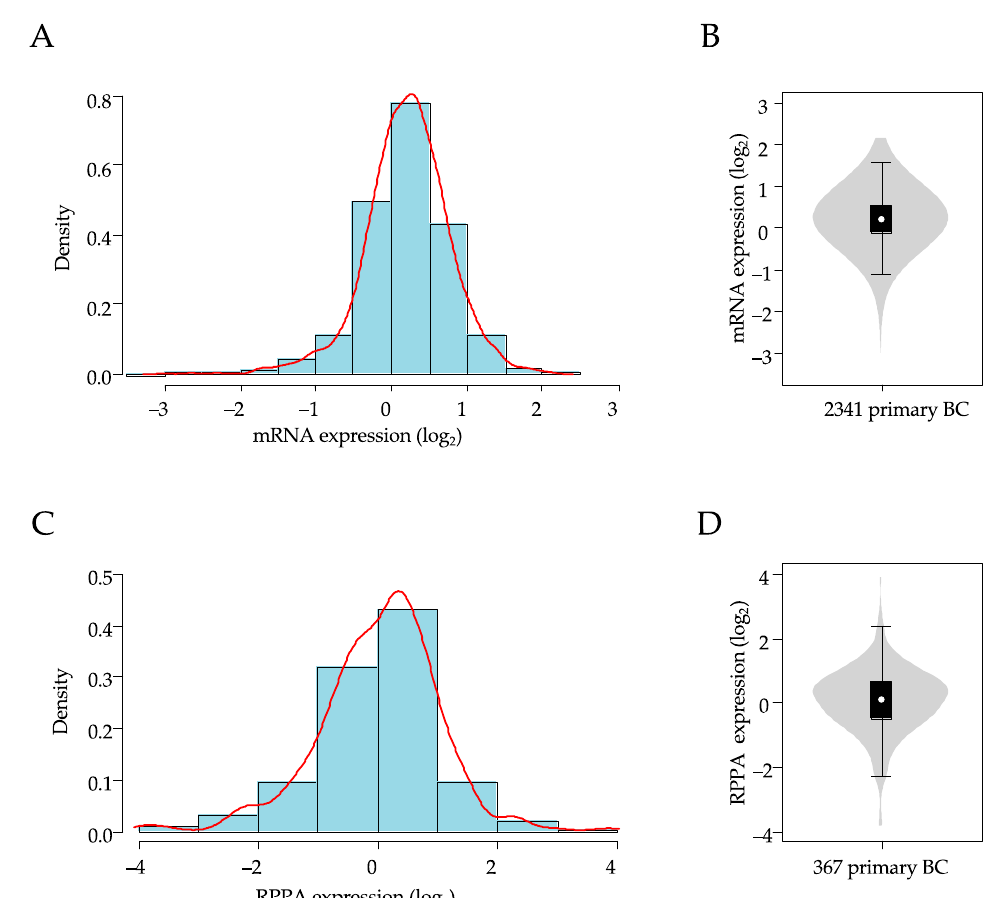
Figure 1. Distribution of XIAP mRNA and protein expression in breast cancer samples. ( A ) Histogram of distribution of XIAP mRNA expression levels (log2) across the 2341 clinical samples. The red line represents the density curve of distribution. ( B ) XIAP mRNA expression level (log2) reported as violin plot and box plot. ( C ) Histogram of distribution of XIAP protein expression levels (log2) across the 367 clinical samples. The red line represents the density curve of distribution. ( D ) XIAP protein expression level (log2) reported as a violin plot and box